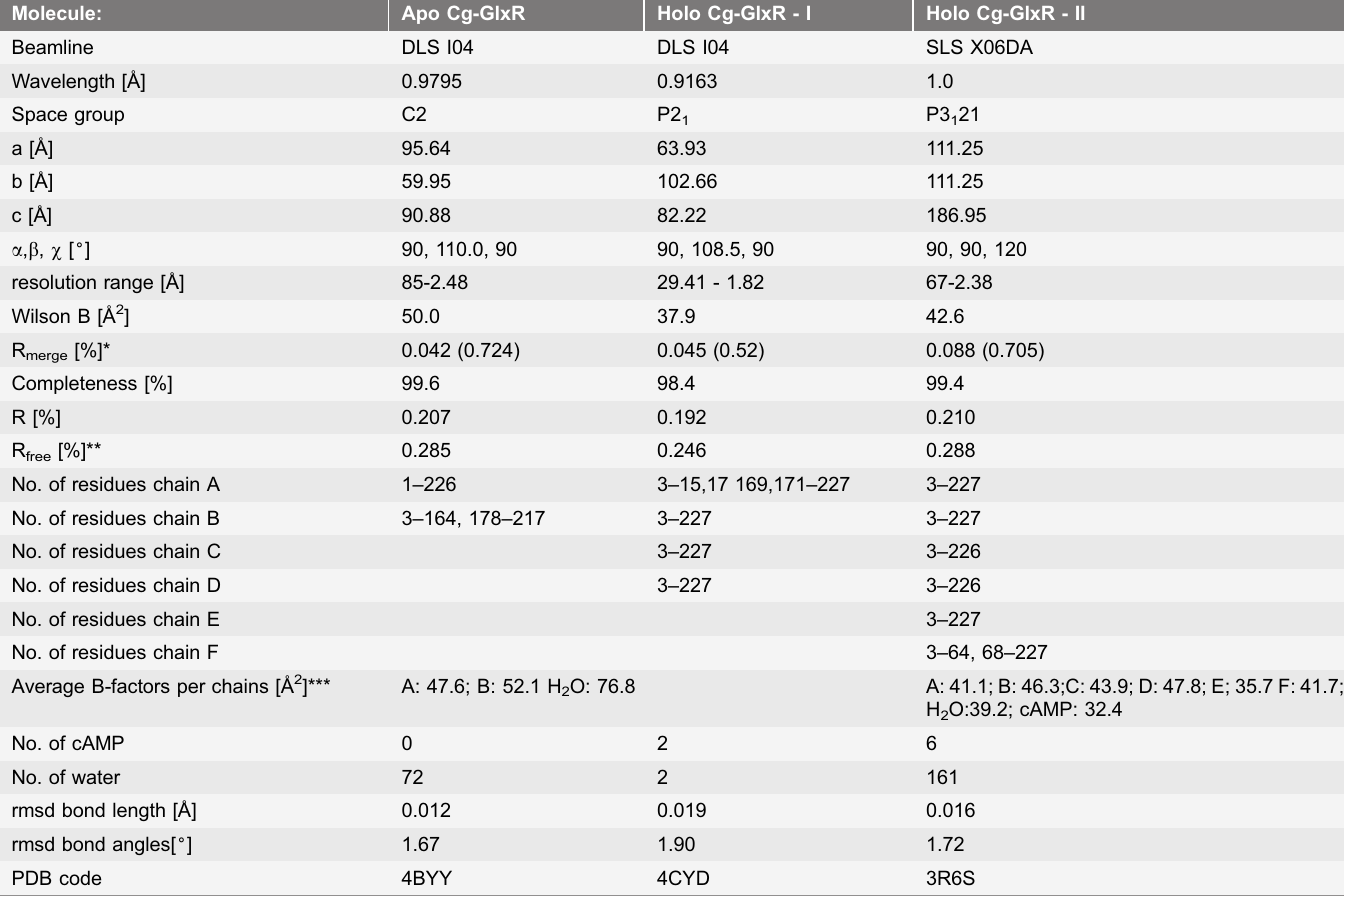
Table 1. Data collection and refinement statistics.